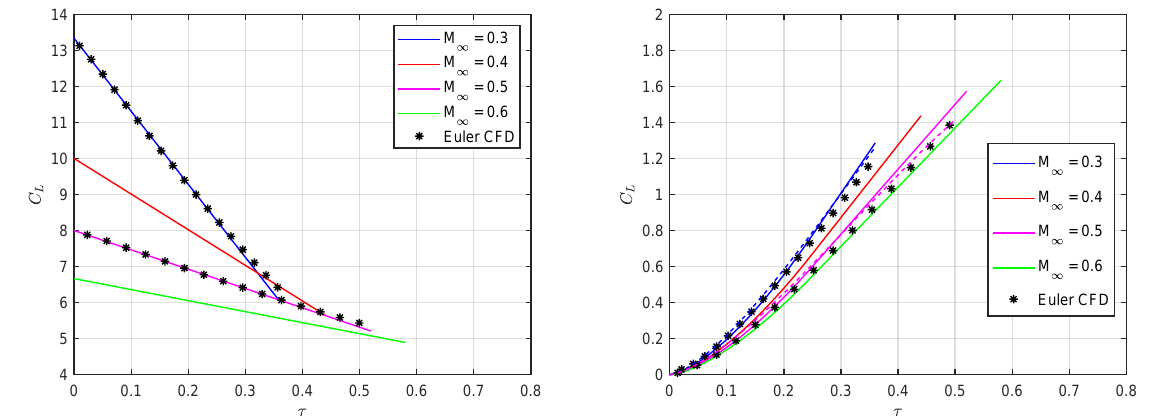
Figure 8. The incipient indicial lift for elliptical wing in compressible flow: AOA ( left ) and SEG ( right ), with η = 6.